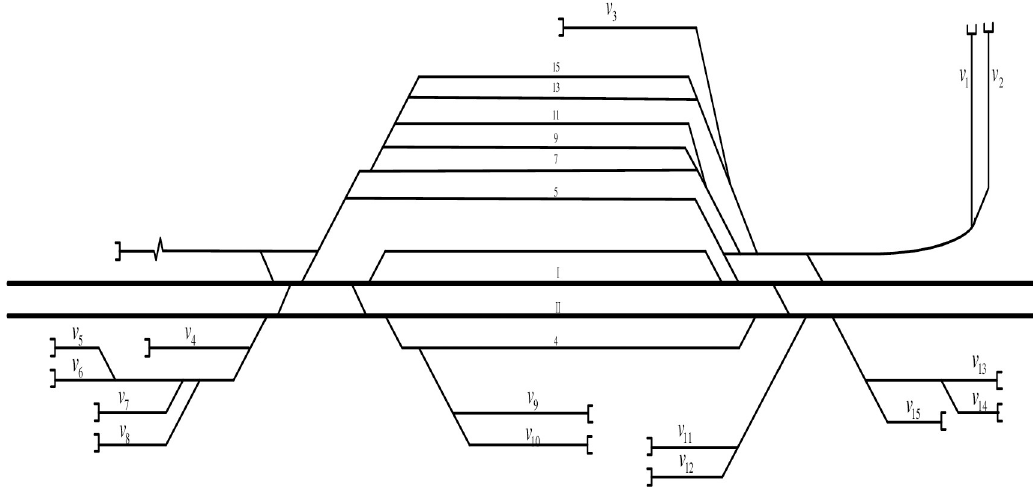
Fig 6. Schematic diagram of the experimental station.